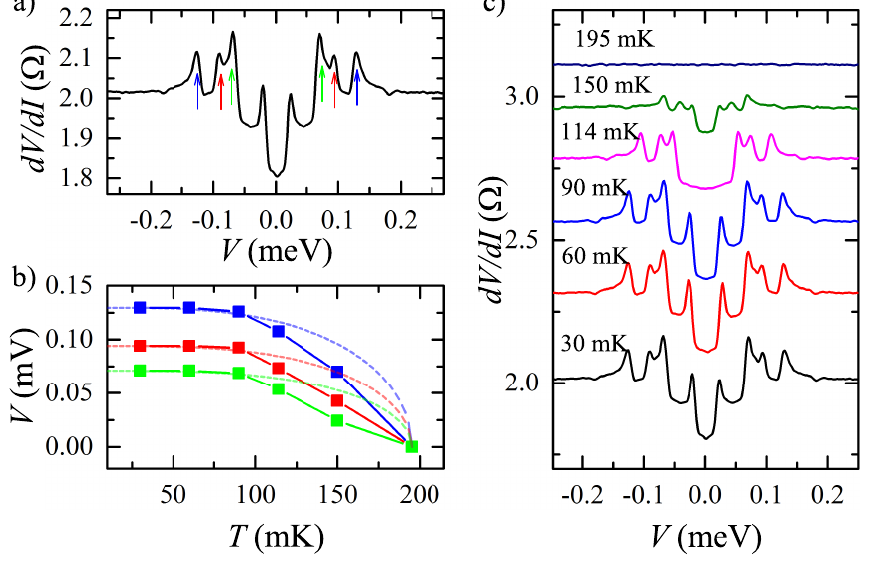
Figure 2. (Color online) ( a ) Non-Ohmic behavior of dV / dI ( V ) differential resistance for a single Au-NiTe 2 junction at 30 mK temperature in the zero magnetic field. The dV / dI ( V ) curve shows a prominent dV / dI drop around the zero bias, which is accompanied by several dV / dI peaks at higher biases (denoted by arrows for the positive bias polarity). ( b ) Temperature dependence of the peaks’ positions. The colors correspond to the arrow colors in the ( a ) panel. The standard BCS fit [35] is shown by the dashed lines. ( c ) Temperature dependence of the dV / dI ( V ) curves in the zero magnetic field. The central dV / dI drop is diminishing with the temperature, while dV / dI peaks’ positions also move to the zero bias. The curves are shifted for